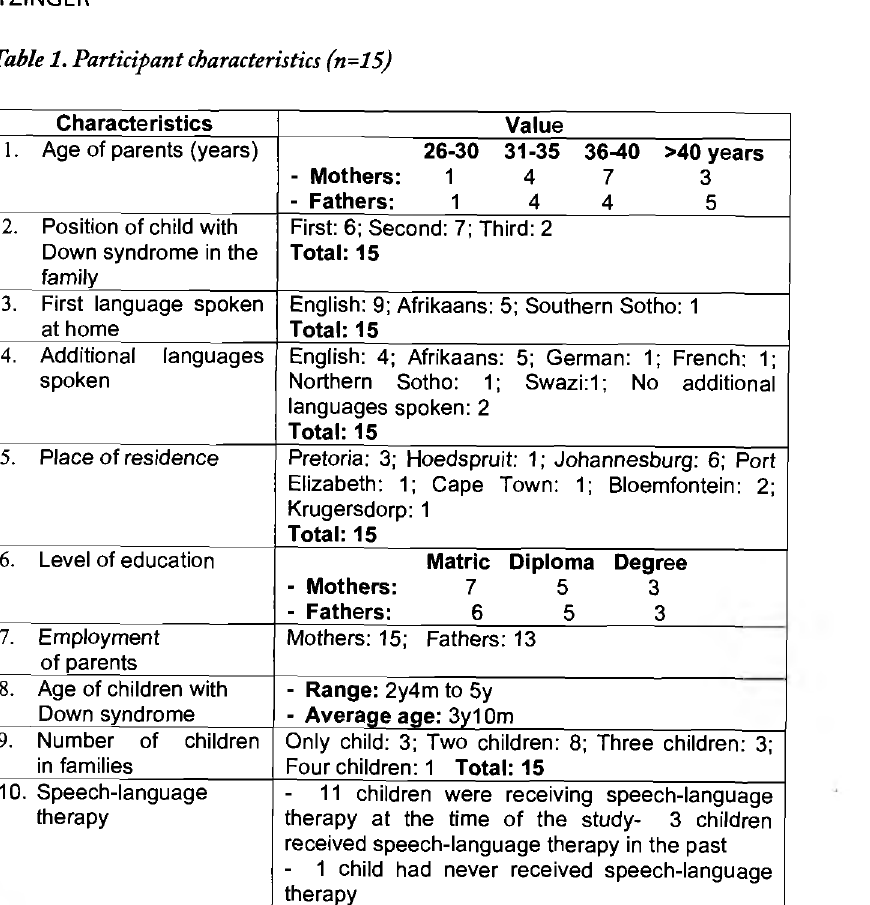
Table 1. Participant characteristics (n=15)